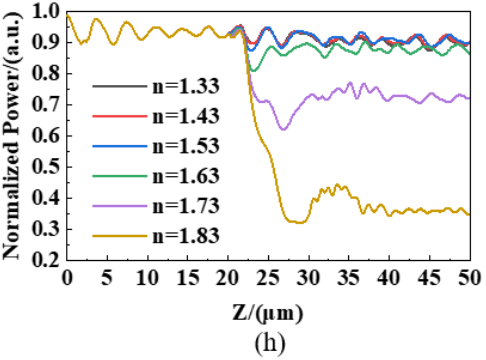
Figure 8. The dependence of the normalized output power of the embedded OW on refractive indexes of the detected material.